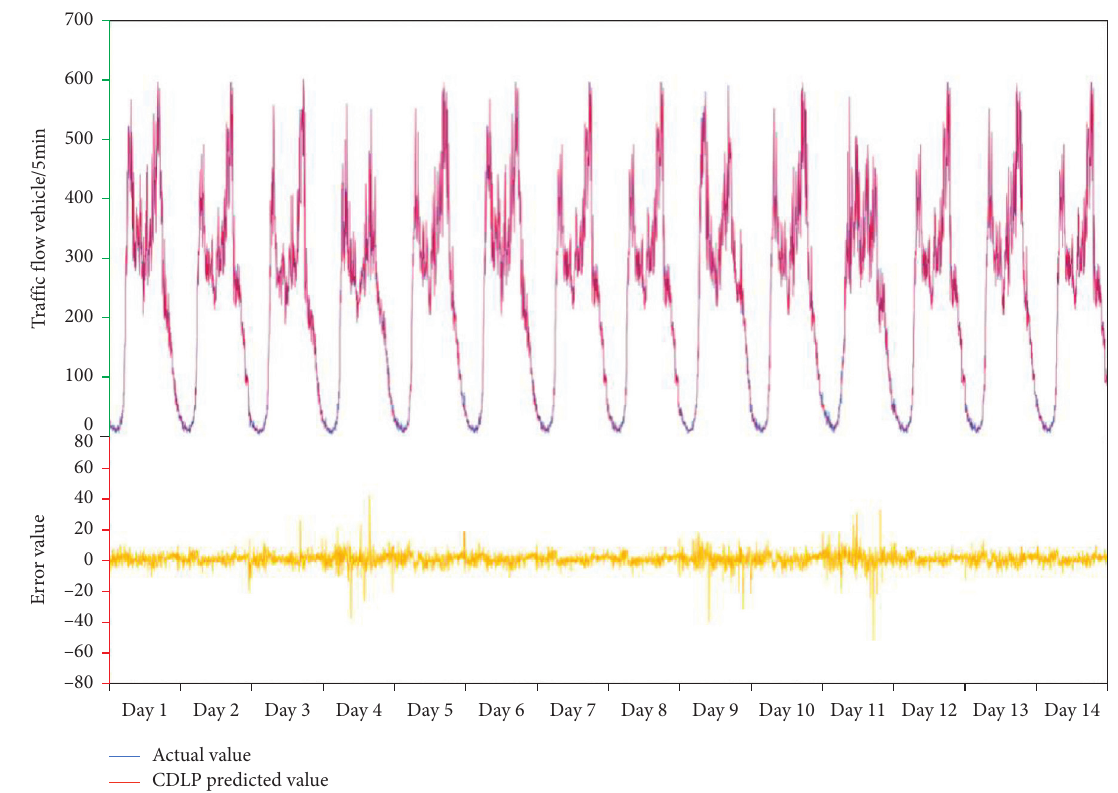
Figure 6: The prediction results of the CDLP model for the test